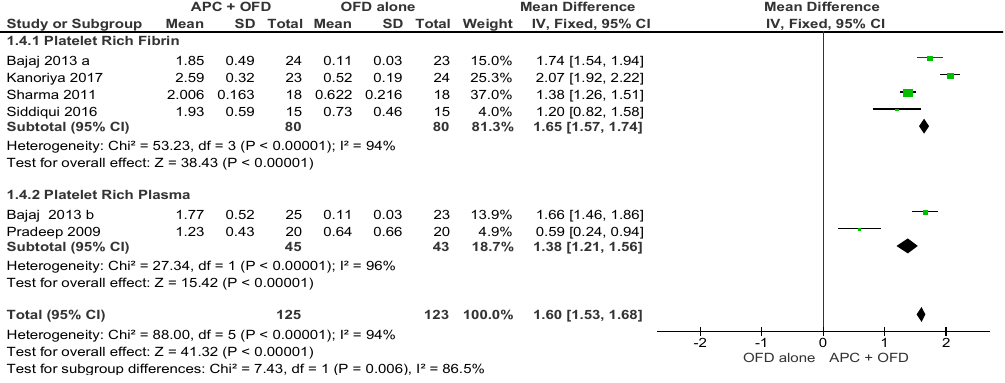
Figure 9. Forest plot showing the effect on vertical furcation depth for comparison of APC + OFD versus OFD alone at end of all-follow-up (6–12 m) .